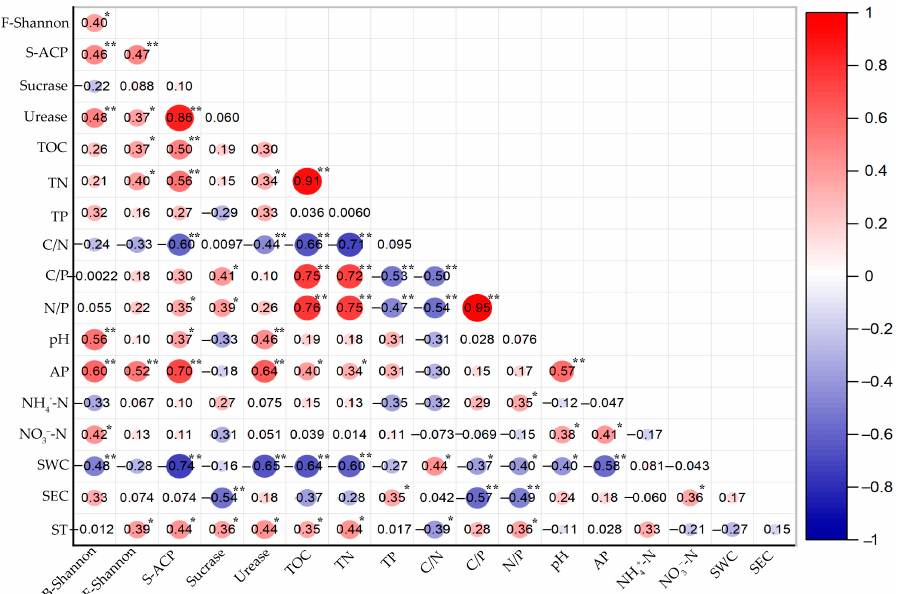
Figure 8. Pearson correlation coefficients between the soil physicochemical properties, the enzyme activities, and the microbial alpha diversity. B–Shannon index: the bacterial Shannon index; F–Shannon index: the fungal Shannon index; NH 4+ -N: ammonium nitrogen; NO 3– -N: nitrate nitrogen; AP: available phosphorus. The value shows the correlation coefficient, positive values represent positive correlation and negative values represent negative correlation. * p < 0.05, ** p < 0.01.